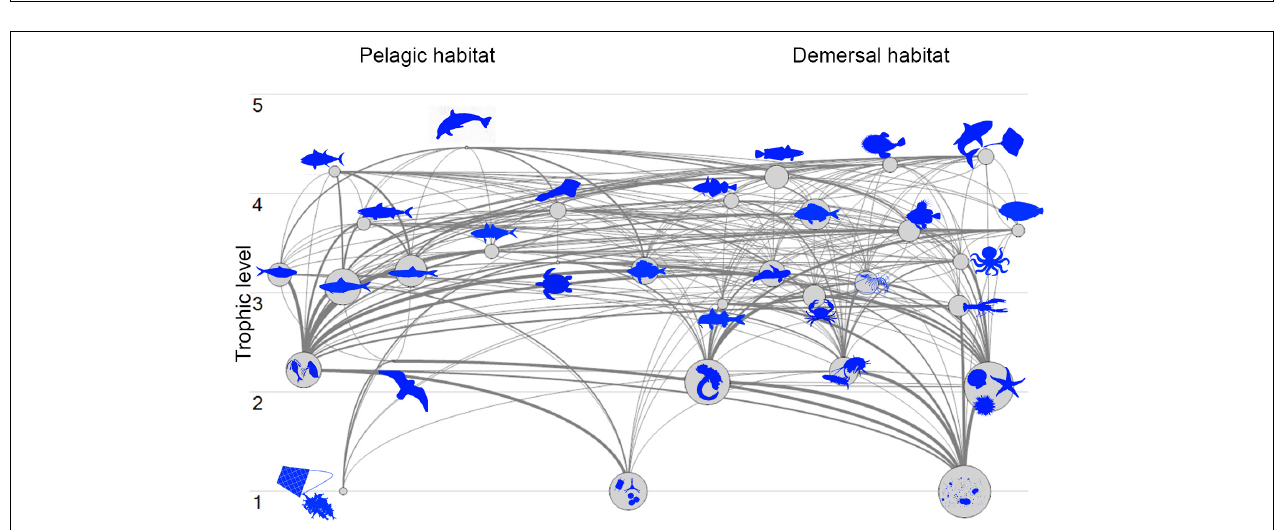
FIGURE 3 | Flow diagram of Pagasitikos Gulf organized by 31 functional groups’ trophic levels and by pelagic or demersal habitat (organisms not in scale).